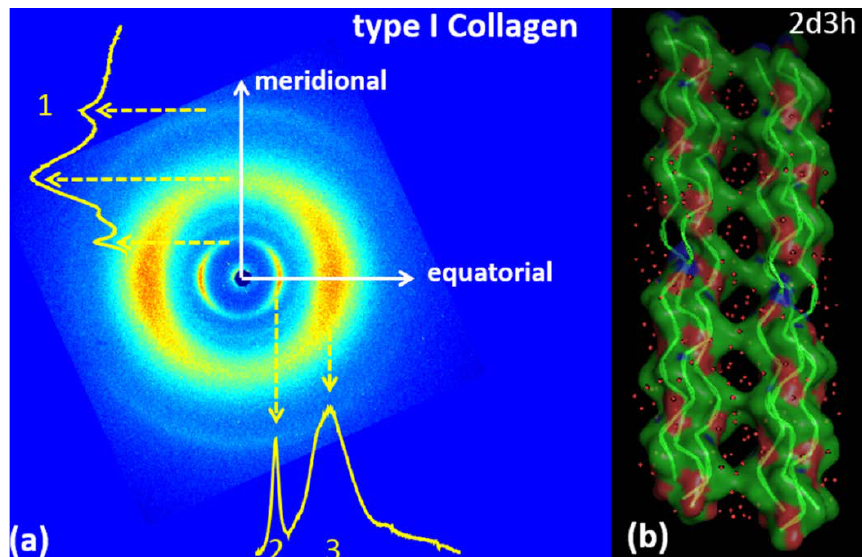
Figure 3. ( a ) Two-dimensional WAXS fiber diffraction pattern of type I collagen with white arrows along the fiber axis (meridional) and perpendicular to it (equatorial). The corresponding 1D WAXS integrated profiles show the main peaks of the protein, the meridional peak (marked as 1) and the equatorial peaks (marked as 2 and 3), respectively; ( b ) 2d3h molecular model of type I collagen.